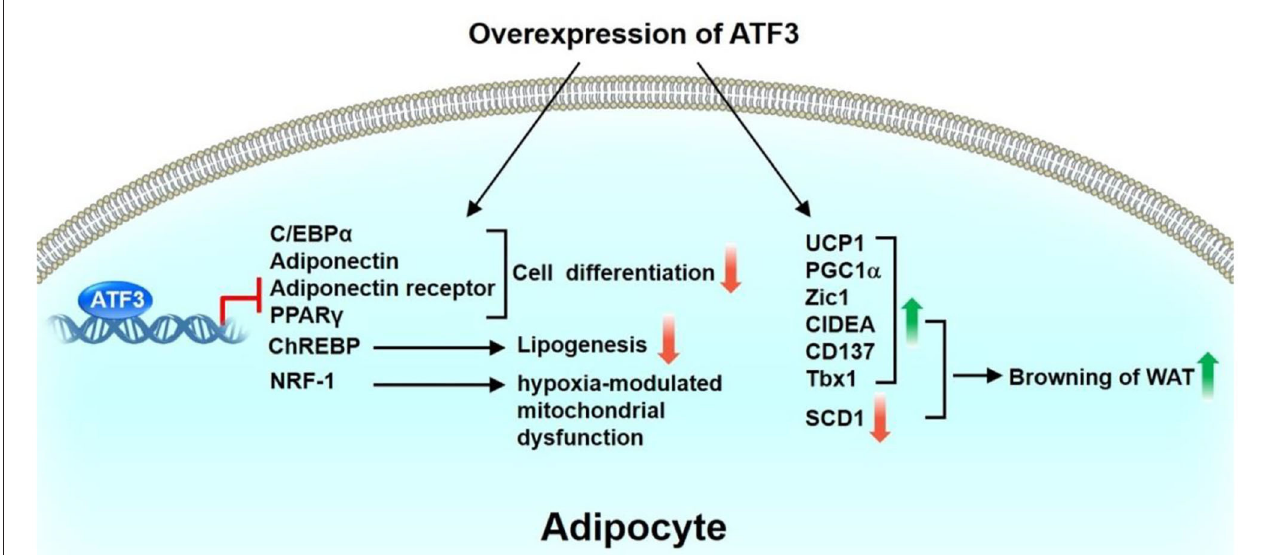
FIGURE 2 | Role of ATF3 in adipose tissue. ATF3 inhibits adipocyte differentiation by negatively regulating the expression of adipogenic genes, including C/EBP α , adiponectin, adiponectin receptor, PPAR γ . In addition, ATF3 suppresses ChREBP expression to inhibit lipogenesis of 3T3-L1 adipocytes. ATF3 is also involved in adipocyte hypoxia-modulated mitochondrial dysfunction in obesity via repression of NRF-1 expression. Overexpression of ATF3 induced transdifferentiation of white adipocytes to beige/brown adipocytes in vitro by upregulation of BAT/beige genes (UCP1, PGC1 α , Zic1, CIDEA, CD137, Tbx1) and downregulation of SCD1. Taken together, these findings indicate that ATF3 plays a beneficial role in regulating adipogenesis, lipogenesis, and browning in adipocytes.